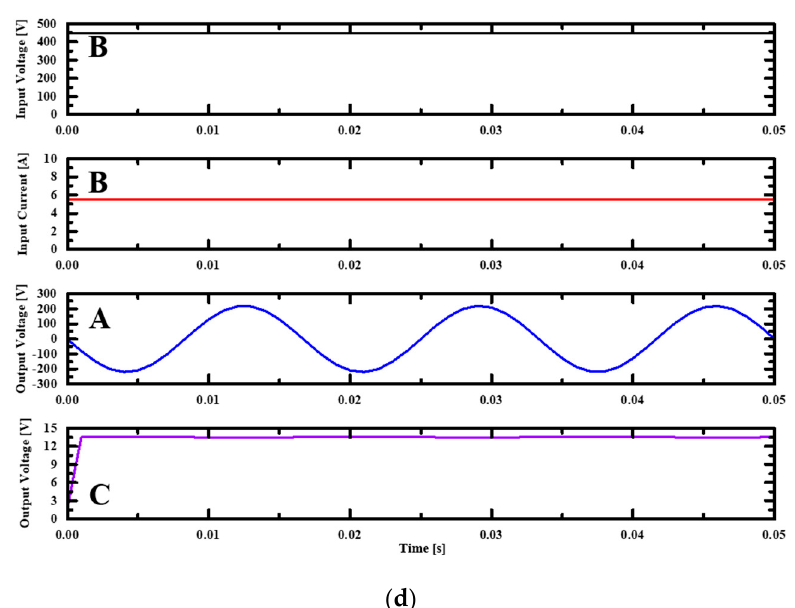
Figure 6. Input and output voltages of the integrated module in ( a ) Mode 1, ( b ) Mode 2, ( c ) Mode 3, and ( d ) Mode 4.